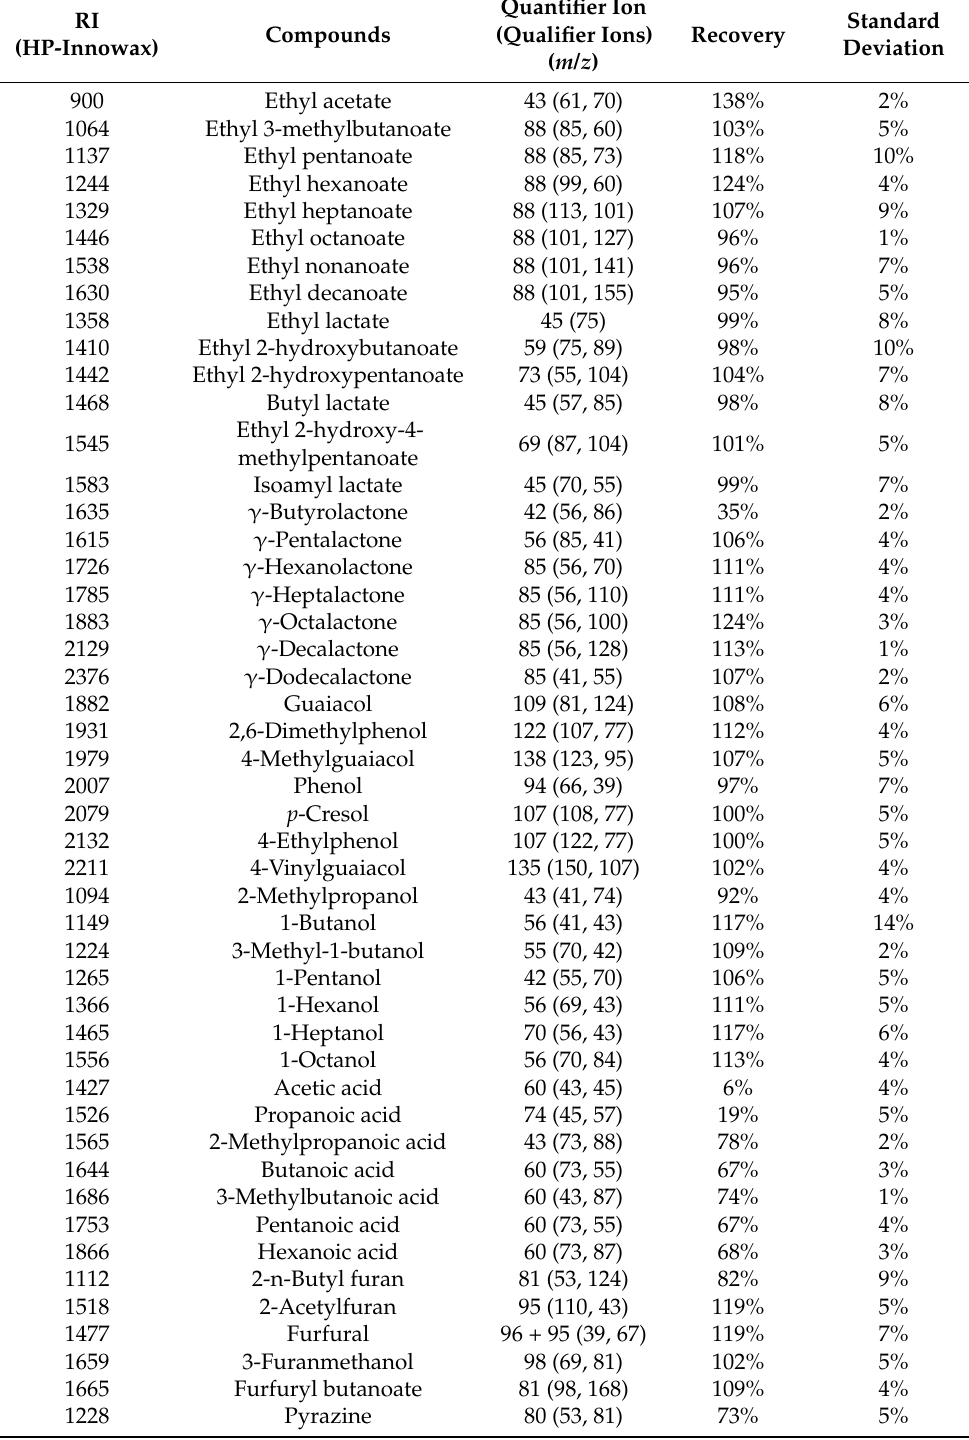
Table 1. Recovery of volatile compounds extracted by LiChrolut EN